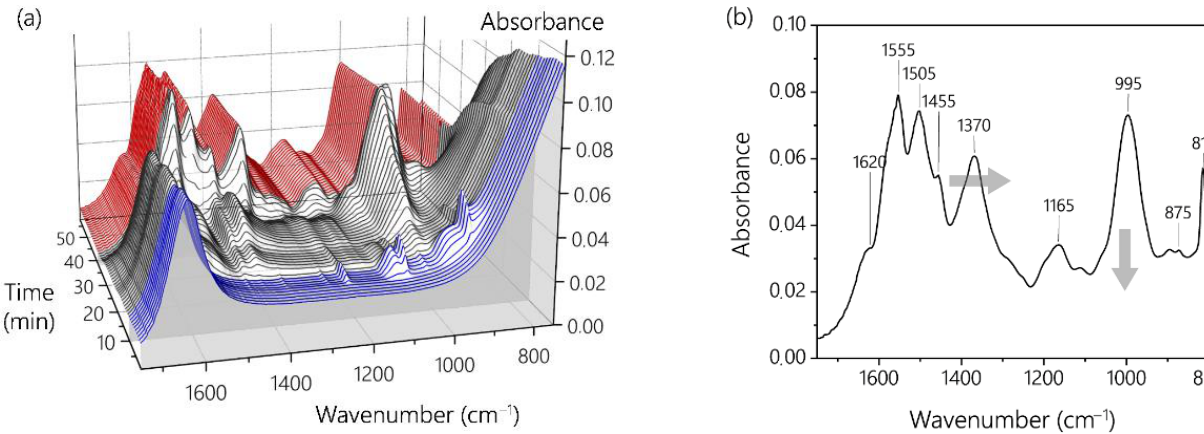
Figure 4. Infrared spectra in the spectral range from 1750 to 750 cm −1 . ( a ) 3D plot of IR spectra during an entire MF resin synthesis procedure. The initial phase of filling the reactor is colored in blue. The subsequent phase of dissolving melamine via methylolation until a clear reaction mixture is obtained is colored in black. The subsequent phase of chemical changes occurring in homogenous solution (resin condensation) is colored in red. The spectral time course of MF resin with an M:F ratio of 3 and a starting condition of pH 10 (center point) is shown. ( b ) Last spectrum of this time series at the end of the synthesis giving the characteristic spectral fingerprint of the resin. The arrows indicate the directions of the most significant changes during the condensation phase.